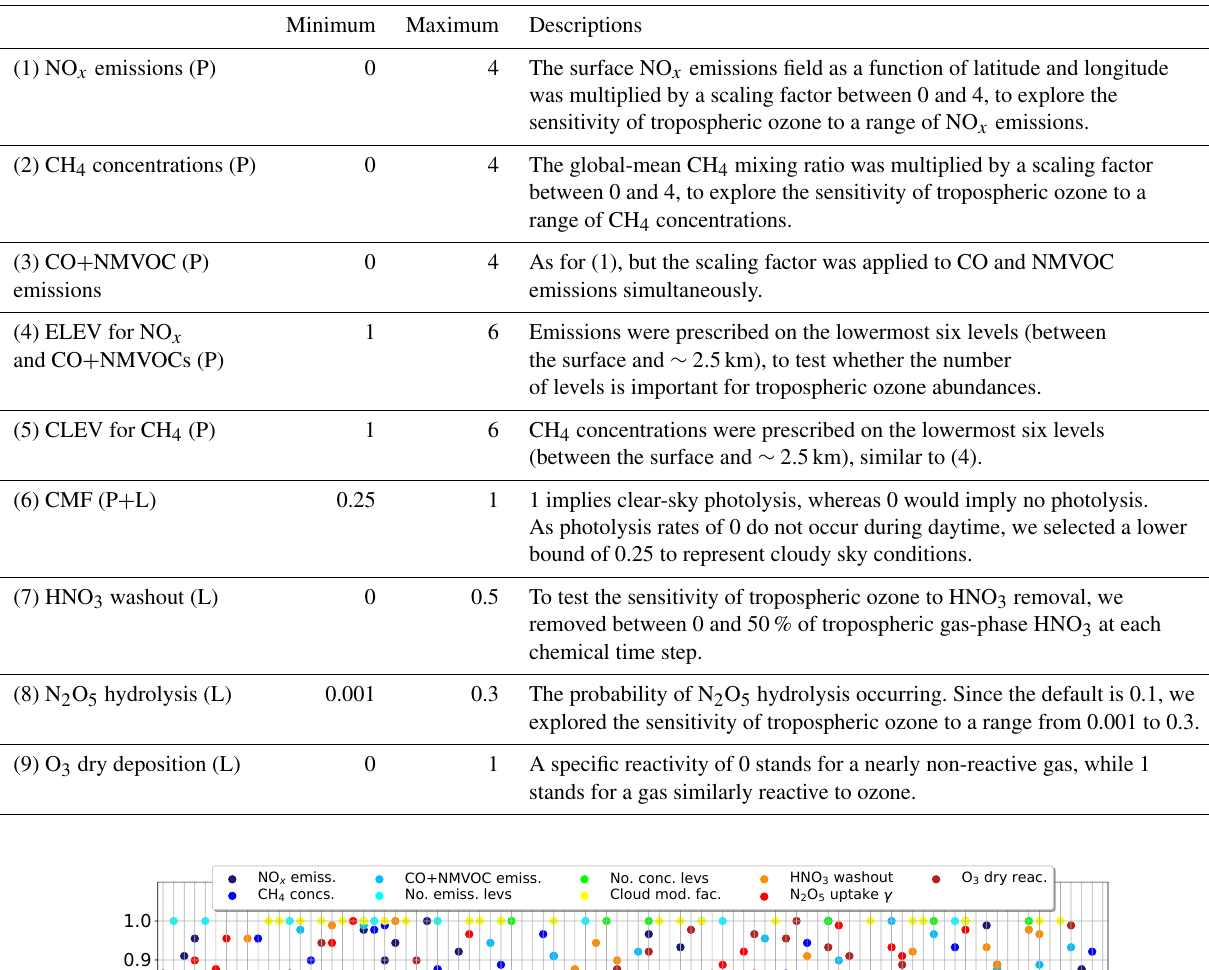
Table 1. Range of the sensitivity forcings/parametrizations. P and L indicate whether the variable is of relevance to ozone production and/or loss, respectively.